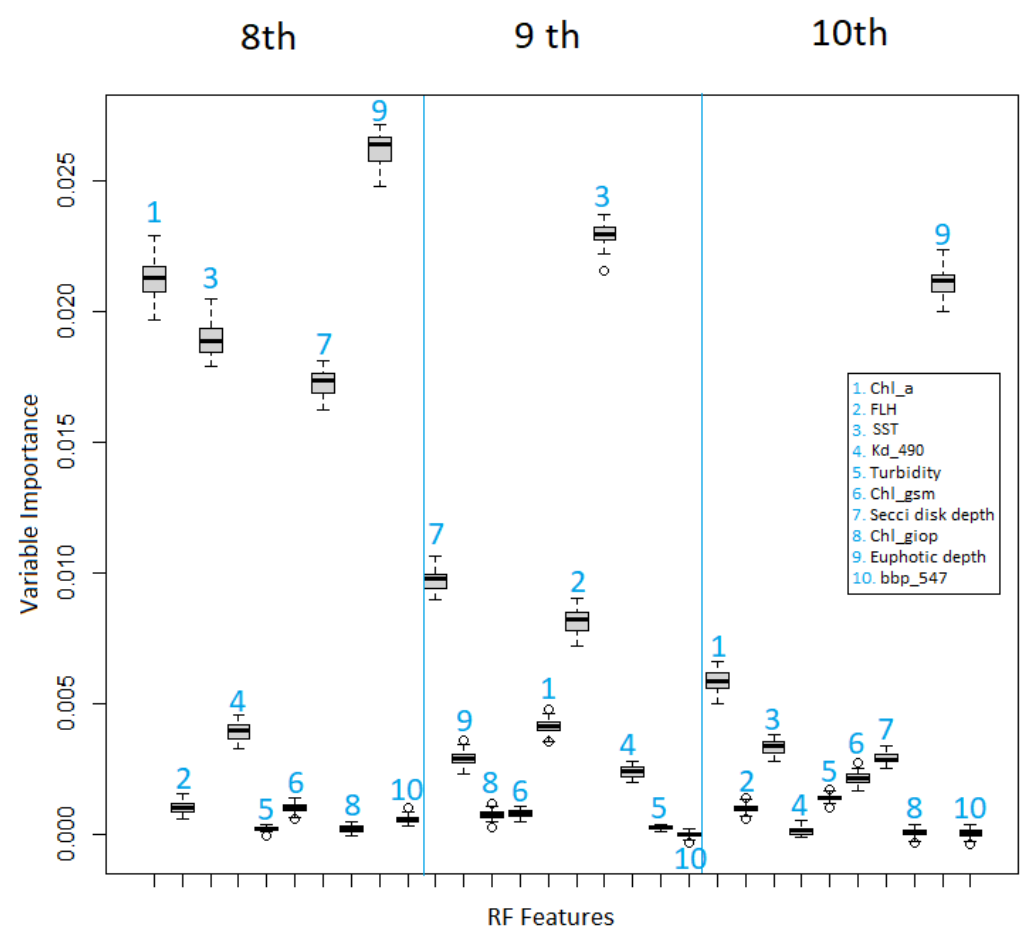
Figure 6. Variable importance (VI) boxplot for the best RF model. The VI metrics are on the y-axis and the 10 variables for each of the 3 consecutive days are numbered.